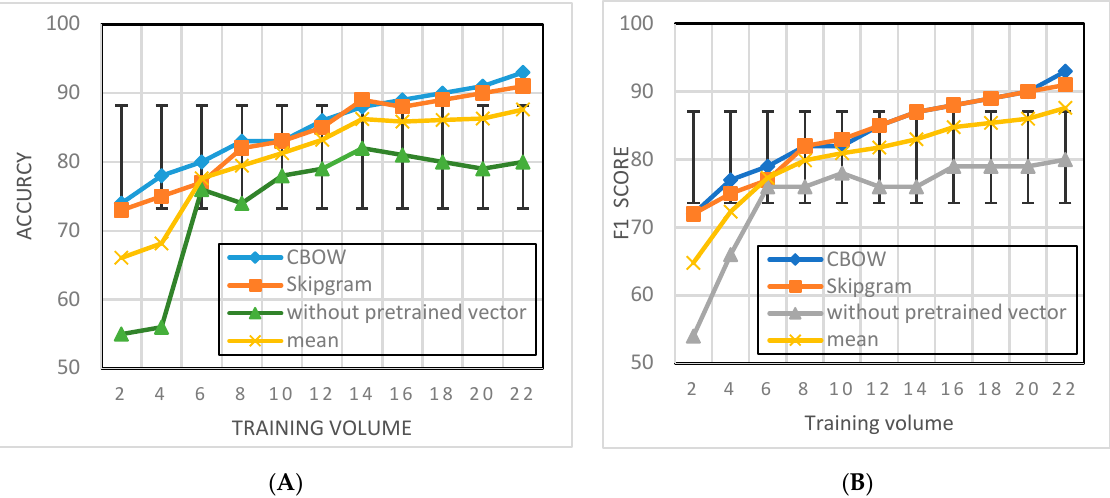
Figure 7. CNN with word2vec. ( A ) Accuracy; ( B ) F1 score.